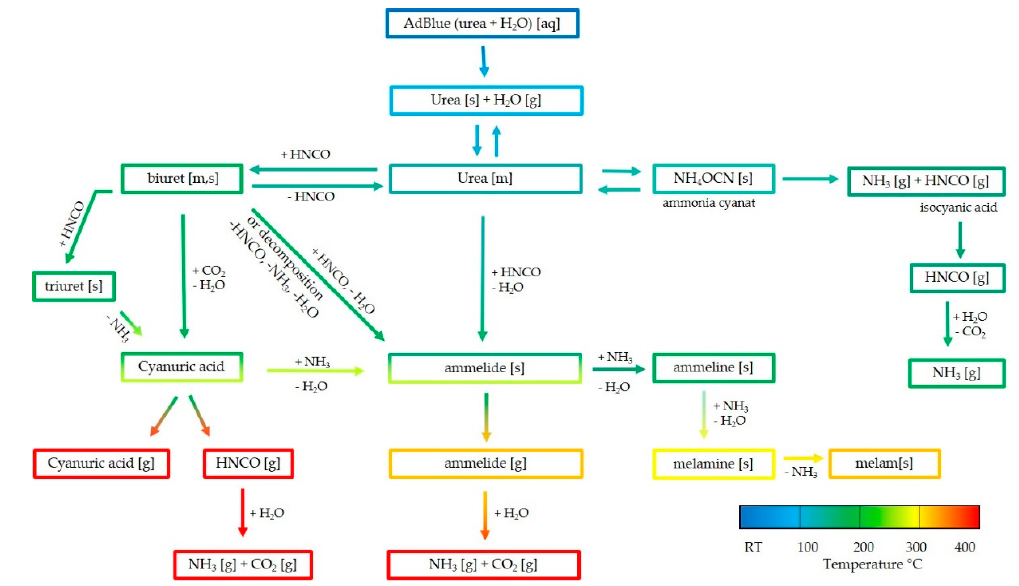
Figure 1. Scheme of aqueous urea decomposition under heating [22–24].